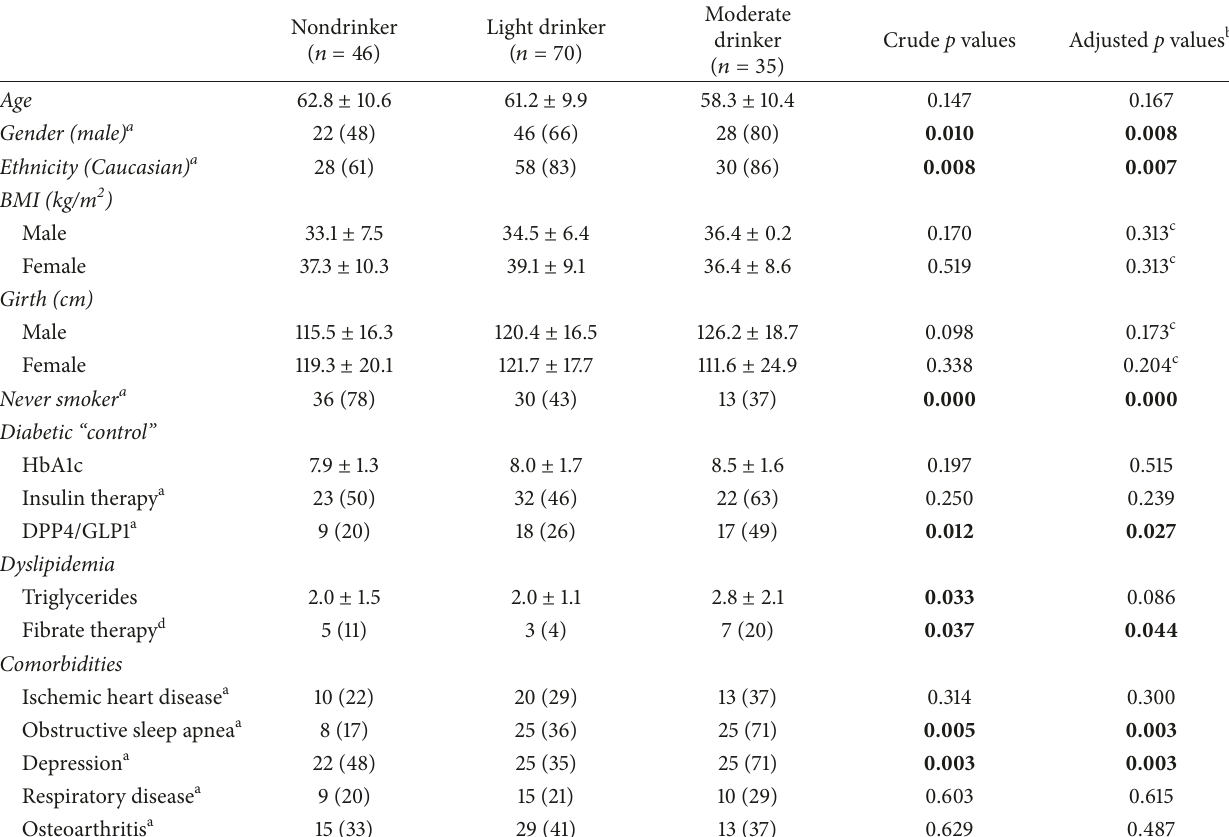
Table 1: Demographic and clinical characteristics of the 151 subjects according to lifetime drinking